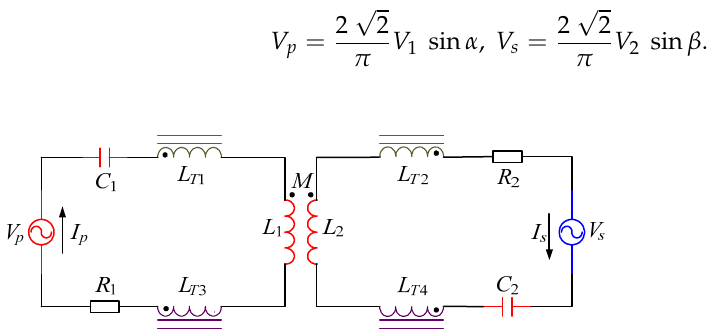
where φ is the phase shift angle generated between the primary side and the secondary side control signal. According to the Kirchhoff’s theorem, the circuit equation is obtained. Figure 3. The schematic diagram of the SWIPT system equivalent circuit. Figure 3. The schematic diagram of the SWIPT system equivalent The power transfer frequency is necessary to work at the circuit resonance frequency. C 1 and C 2 compensate the inductance of the primary and secondary coils. The power res- onant angular frequency ɷ p is obtained from the inductance and compensation capaci- tance values in the circuit.